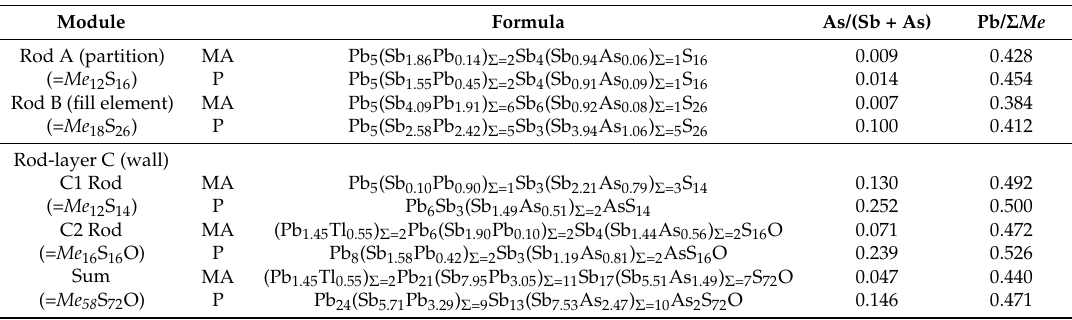
Table 4. Comparison of module compositions between crystal structures of chovanite from Monte Arsiccio (MA—this study) and Pollone (P—[2]).